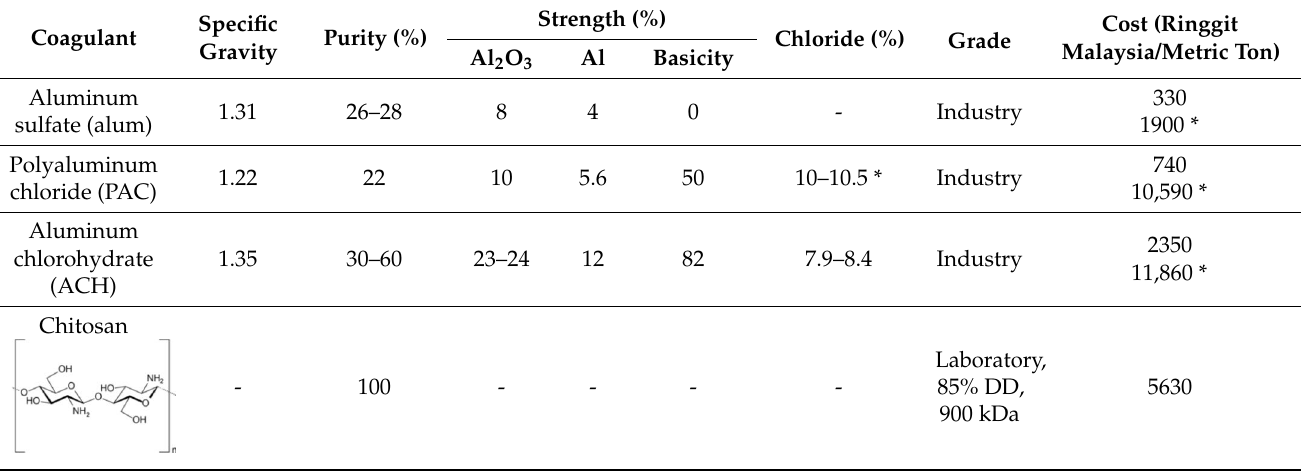
Table 2. Coagulants’ properties and grades.